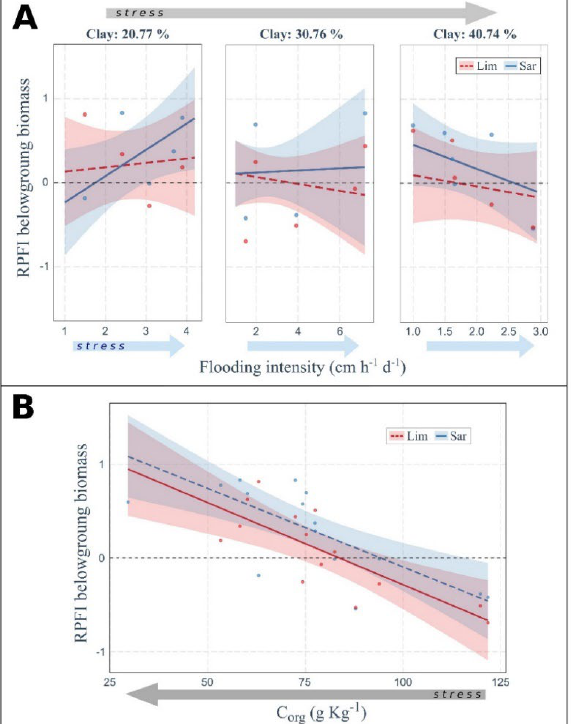
Figure 4. Combined effects of flooding intensity and soil texture and of soil organic C on plant fitness in terms of belowground biomass. Positive values of RPFI denote larger fitness of the species when growing in plurispecific stands compared to monospecific plant communities. Arrows indicate the increasing stress gradient of flooding (light blue arrow) or of harsher soil conditions (grey arrow, i.e., increasing soil clay content ( A ) or decreasing soil organic C ( B ). Only significant relationships ob- tained from the ANOVA applied on linear models are shown (see Table S3, R 2 = 0.21 for ( A ); R 2 = 0.59 for ( B )). Lim or Sar labels indicate the target species Limonium narbonense or Sarcocornia fruticosa , respectively. Non-significant difference of RPFI between the two species was